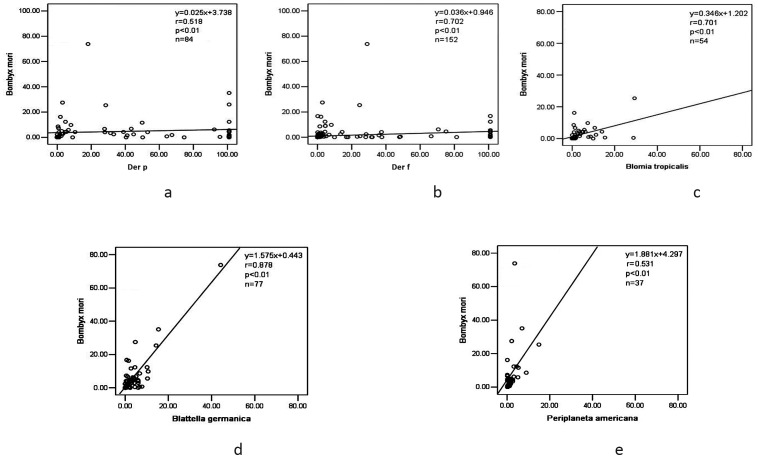
Spearman rank correlation in serum sIgE value between silkworm moth (Bombyx mori) and 5 common inhalant allergens: Der p (Figure 1a), Der f (Figure 1b), Blomia tropicalis (Figure 1c), Blattella germanica (Figure 1d), and Periplaneta americana (Figure 1e).